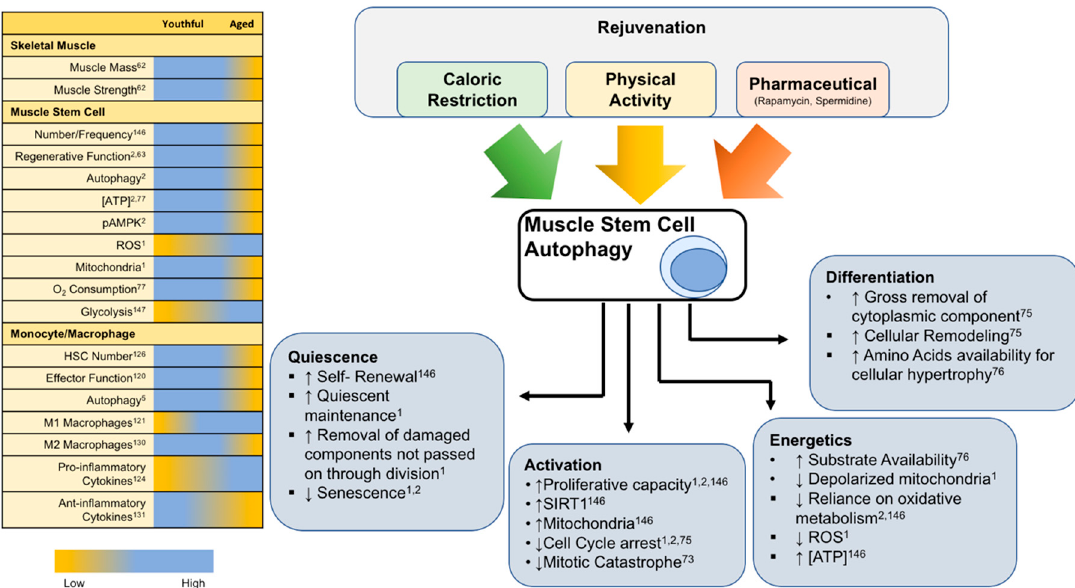
Figure 6. Rejuvenation of Muscle Stem cell autophagy. Left : Chart summarizing various physiological and functional parameters involved in skeletal muscle regeneration and how they are susceptible to age-related alterations. Right : Conceptualization of the rejuvenation potential targeting stem cell autophagy and how various cellular functions are affected. Caloric restriction, physical activity, and certain pharmaceuticals are known to affect stem cell autophagy. The role of autophagy in the stem cell is multifaceted with implications in quiescence vs. senescence, activation/proliferation vs. apoptosis, and differentiation outcomes. A substantial contribution of autophagy in the function of a muscle stem cell is alterations in the cellular metabolic landscape or